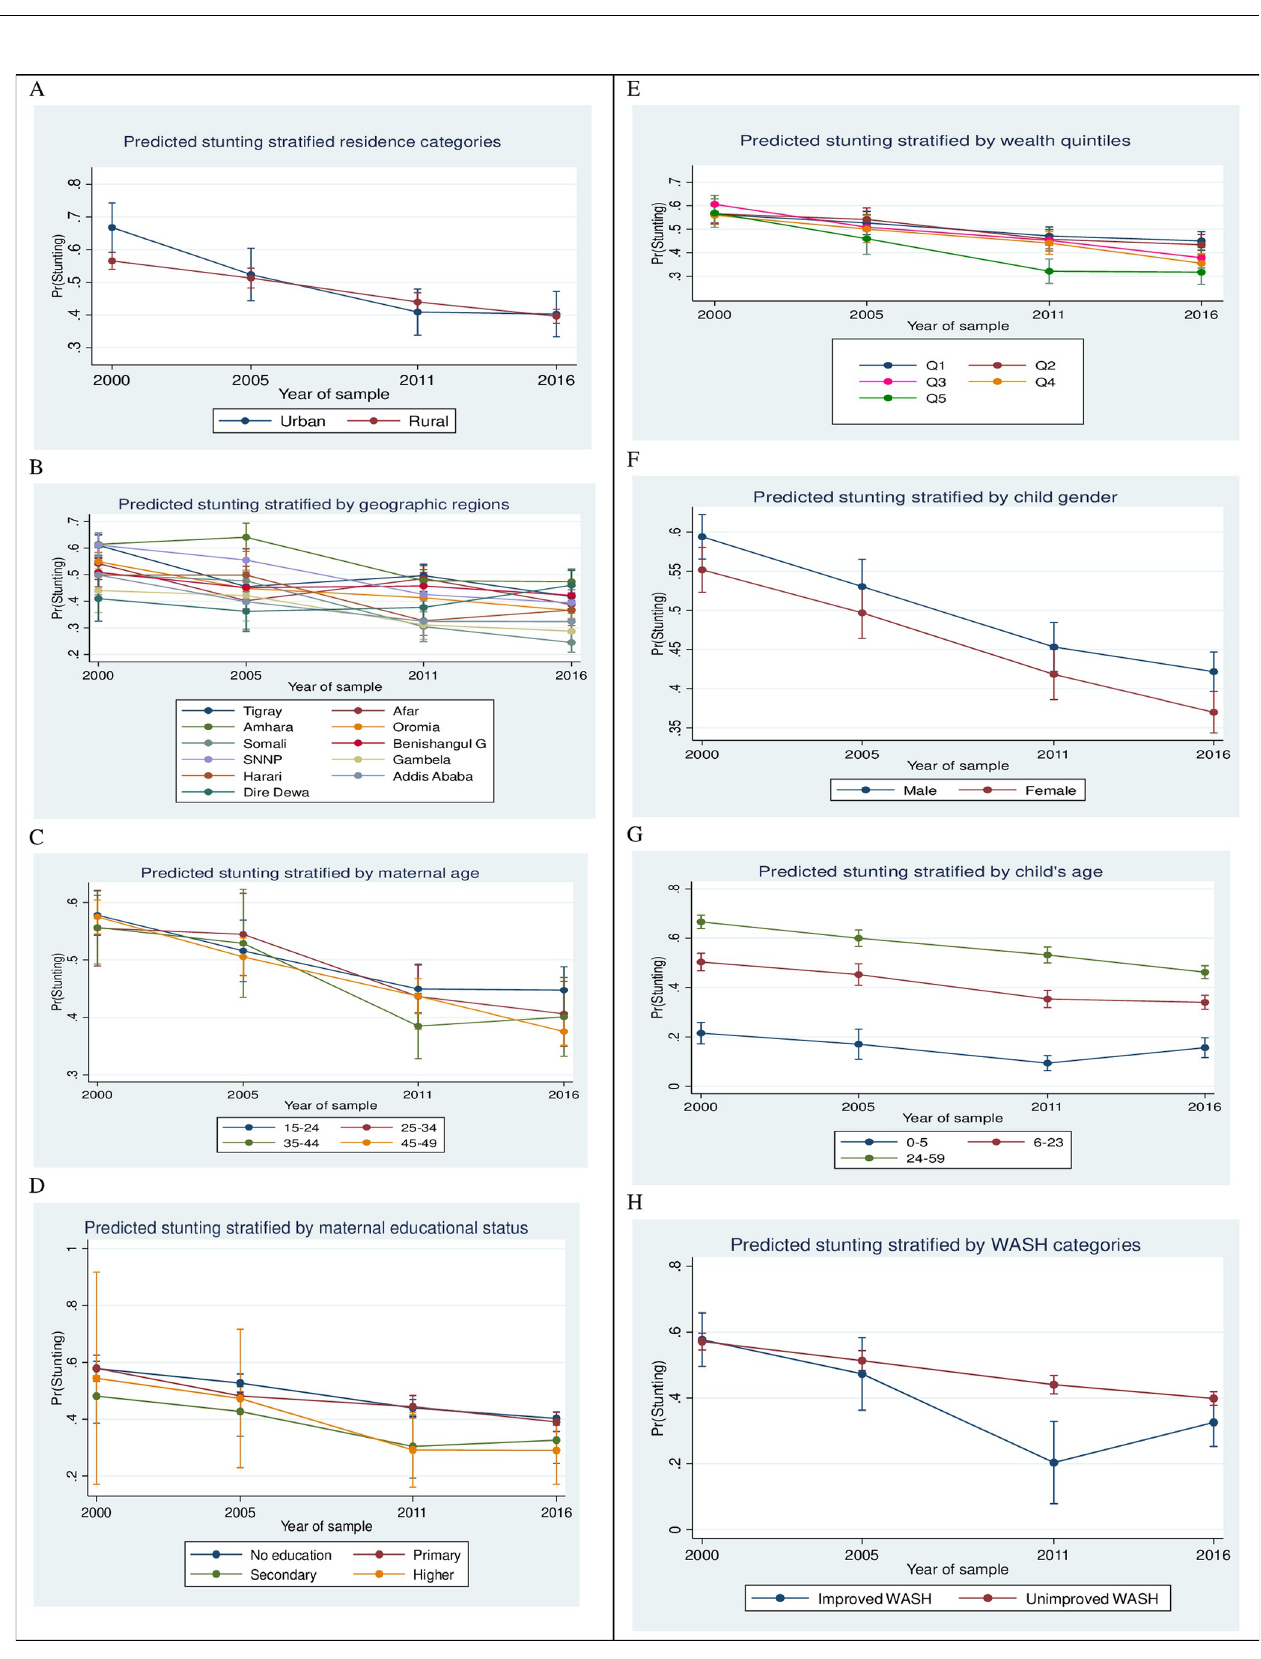
Fig 2. Adjusted predicted probabilities of stunting by key predictors among under-5 children in Ethiopia, EDHS 2000 to 2016.